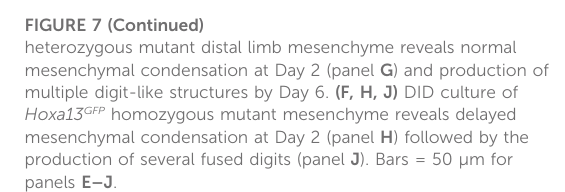
FIGURE 7 Recapitulation of the Hoxa13 mutant limb defects by the DID system. (A) Hoxa13 is robustly expressed in forelimb and hindlimb digitsatE13.5in Hoxa13 heterozygousmutantembryos. (B) Hoxa13 GFP homozygous mutant embryos exhibit poor separation of the hindlimb digits by E13.5. (C, D) Comparison of postnatal day 90 (P90) littermate hindlimbs reveals normal development of digits in heterozygous Hoxa13 GFP mice compared to homozygous mutants thatexhibitlossofdigitI,fusionofdigitIII-IVphalangealelements, and brachydactyly and phalangeal element loss in digit V. Postnatal Hoxa13 GFP limb defects. (E, G, I) DID culture of Hoxa13 GFP